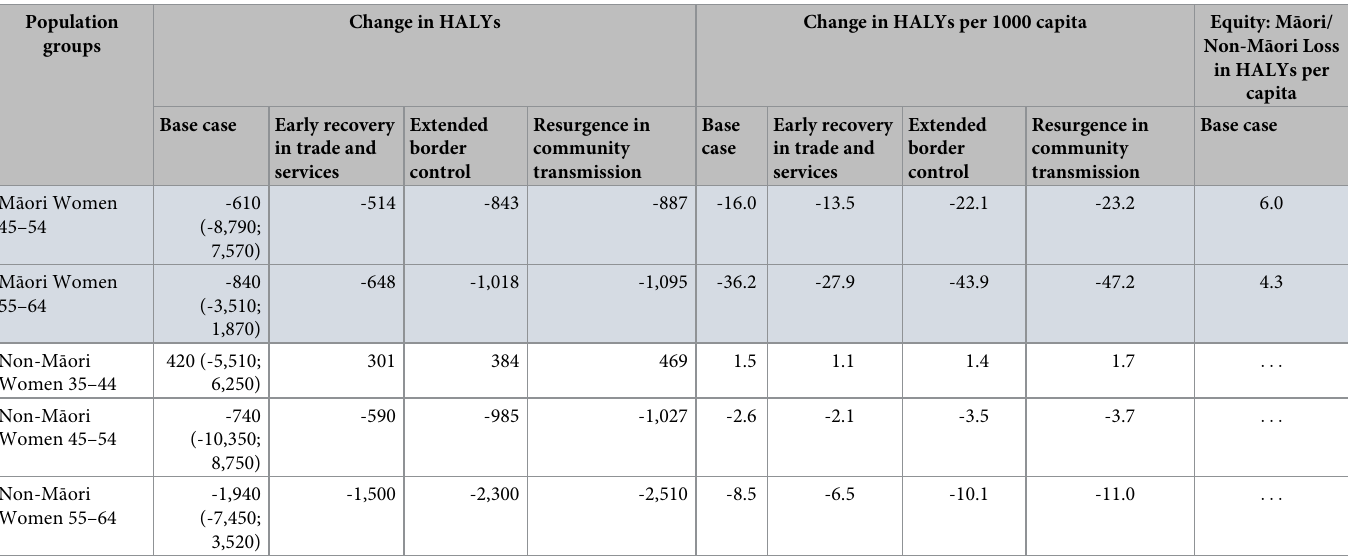
export and services) to 36,900 lost HALYs (resurgence in community transmission) for the different unemployment scenarios. Of which, health loss for M ā ori ranged between -7,700 HALYs and -13,000, and for non-M ā ori from -15,700 to -26,600. For the base case (best-estimate) scenario, health inequities were estimated to increase. That is for M ā ori (Indigenous population) the per capita health loss was 3.7 times greater than for non-M ā ori (49.9 vs 13.5 HALYs lost per 1000 people). M ā ori men suffered the most health loss per capita (95.9 HALYs per 1000 people); however, the worst inequity impacts between M ā ori and non-M ā ori were seen in women aged 45–54 years across all scenarios (six fold dif- ference in per capita health loss). Inequities were exacerbated much more than the sum of existing inequities in CVD burden and unemployment, ie, in some groups, the health loss from CVD burden for M ā ori was increased to six times higher than that of non-M ā ori (com- pared to a double unemployment rate or background CVD burden). The overall pattern of inequity by ethnicity, age and sex was similar for the various modeled economic scenarios. Table 5 presents the additional health costs estimated to be incurred to the NZ health sys- tem due to the higher CVD burden. The estimates ranged between NZ$276 million (m) to unemployment scenarios. Similar to the health burden, 10% of the additional health cost was accumulated in the first five years and more than 60% in the 20 years in the future. The CVD-related health loss, inequities and health costs were similar in terms of relative patterns across scenario analyses and sensitivity analyses (S1–S5 Tables). The equity scenario (Scenario #A, S1 Table) suggested more health loss (-10,800 vs -9,910 HALYs in the base case) and more inequity (up to a ratio of M ā ori/non-M ā ori lost HALYs per capita of 7.1), if M ā ori CVD epidemiology parameters were assumed to be as per non-M ā ori (ie, same risk of CVD mortality and morbidity). Unemployment persisting for 10 years (#B) suggested the most health loss (-57,100 HALYs), and 6% discount rates (#E) resulted in the smallest estimated health loss (-18,500